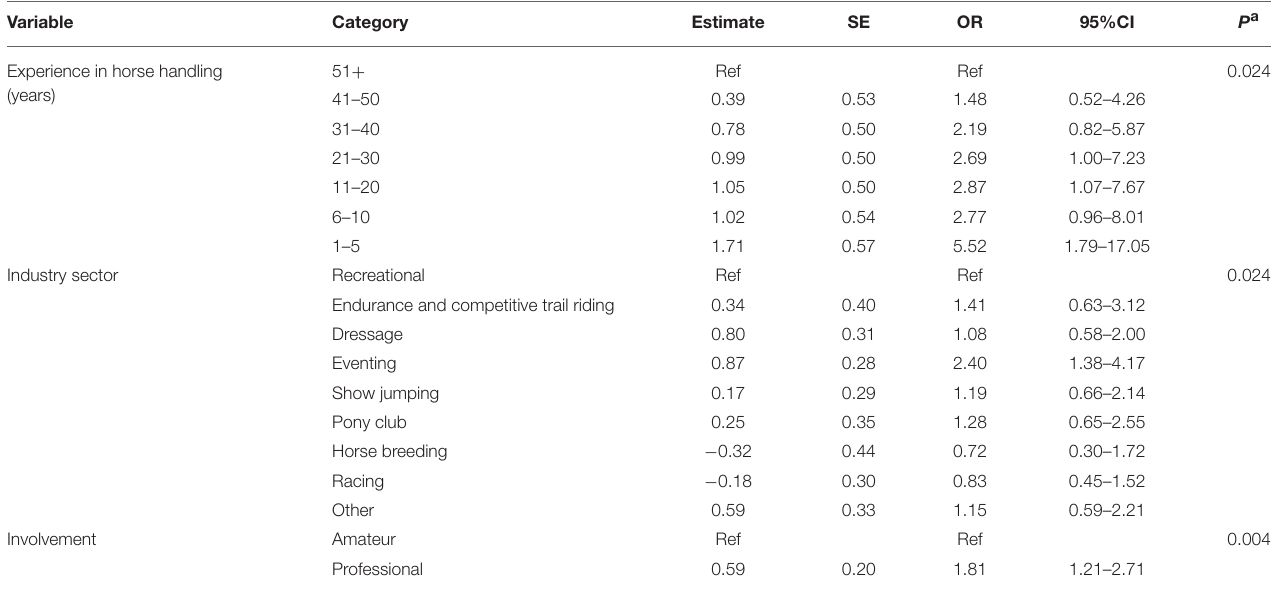
TABLE 5 | Results of multivariate regression analysis of associations between injury and the explanatory variables experience, industry sector, and type of involvement (amateur/professional).